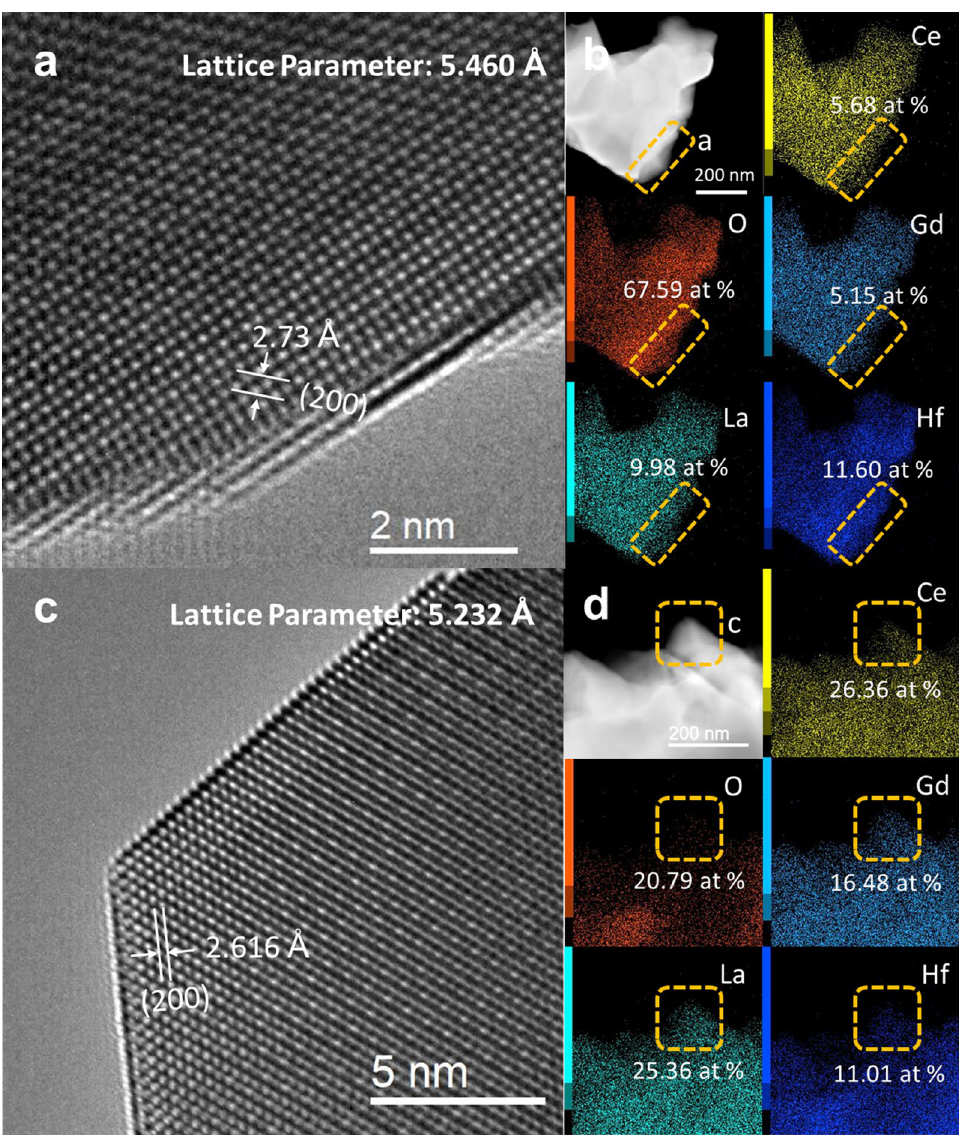
Figure 4. HRTEM image of ( a ) Hf-MPO-1500-Large and ( c ) Hf-MPO-1500-Small. STEM-EDS results: ( b ) corresponds to ( a ); ( d ) corresponds to ( c ). The labeled concentration in STEM-EDS results belong to the region circled by yellow dotted